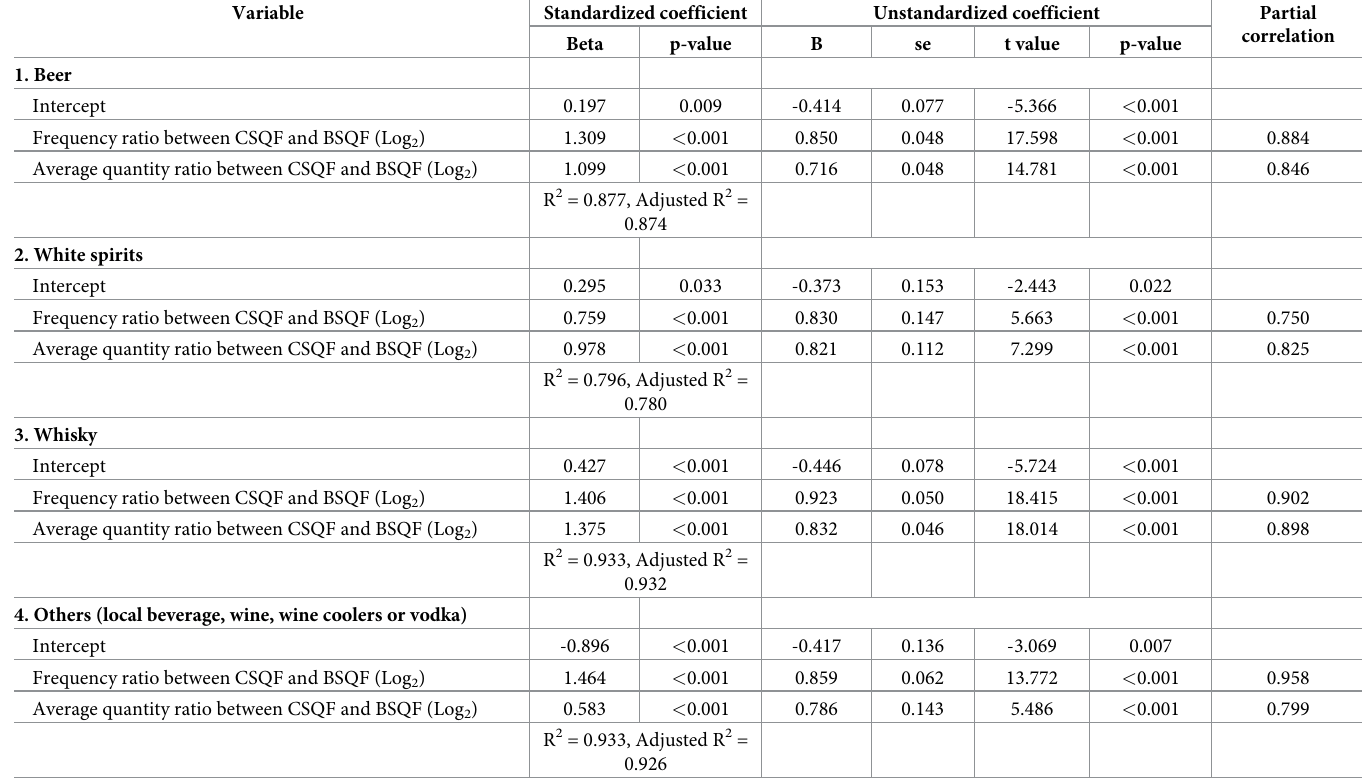
Table 4. Multiple linear regression analysis of the Log 2 ratio of total consumption (dependent variable) against Log 2 ratio of frequency and Log 2 ratio of average quantity (independent variables) between the CSQF and BSQF.